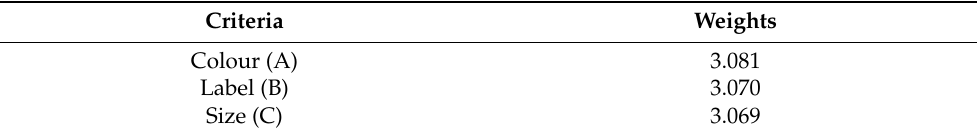
Table 14. The weights matrix—A4.